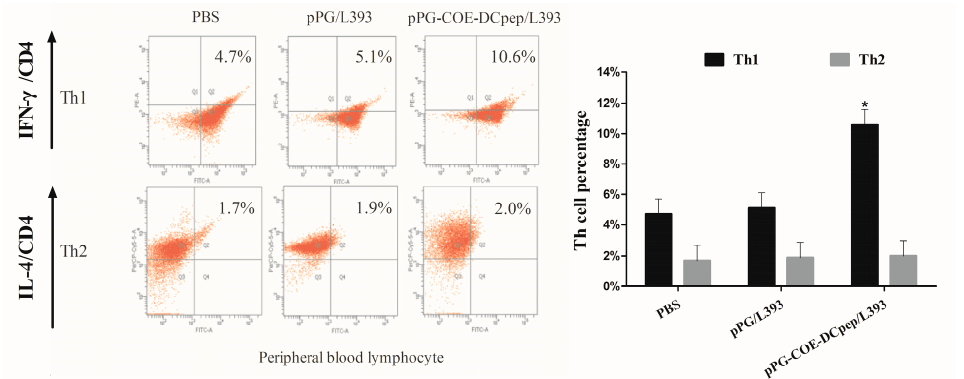
Figure 7. The percentage of T-helper cells after PEDV infection. The piglet groups immunized with pPG-COE-DCpep/L393 , pPG/L393 , and PBS were infected with PEDV (1 × 10 6 PFU/mL) via oral-gastric gavage. T lymph cells of the piglets were collected from peripheral blood, and subjected to an FCM assay, to evaluate the Th1 and Th2 percentages. Flow cytometry analysis of CD4+ cells labeled with FITC, anti-interferon (IFN)- γ conjugated with PE, and anti-interleukin (IL)-4 labeled with PerCP-Cy5.5. To analyze the immune cell frequencies in peripheral blood T lymphocytes, flow cytometry analysis of the percentage of T helper cell phenotype, as gating CD4+ IFN- γ + and CD4+ IL-4+ was performed. Statistical differences (* p < 0.05) are indicated by an asterisk. The results are represented as the mean ± SEM of three independent